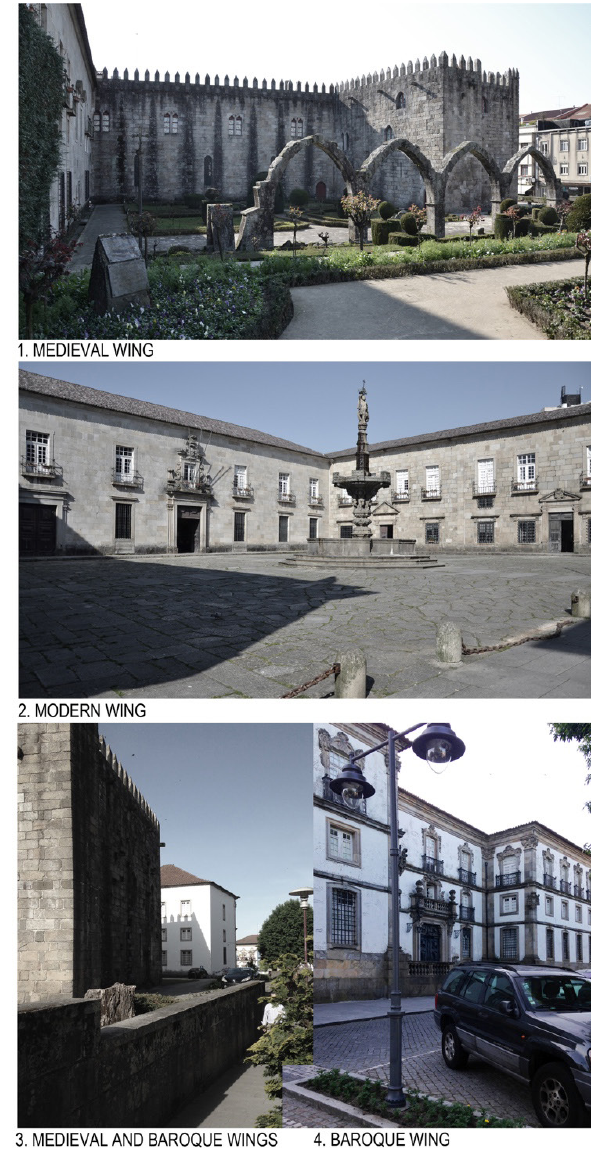
Figure 2. Archbishop’s